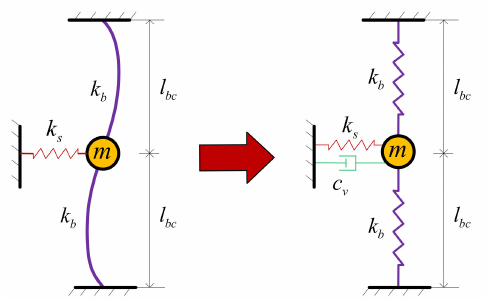
Figure 12. Simplified model of the buckled beam